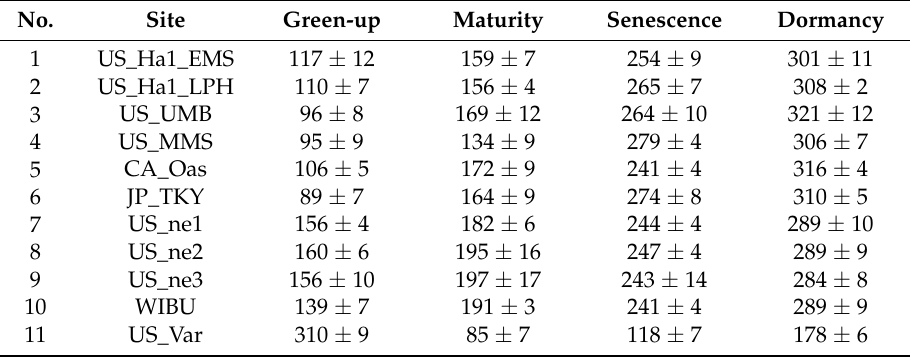
Table 2. The four phenological transition dates of vegetation at each site (mean day of year (DOY) ± standard